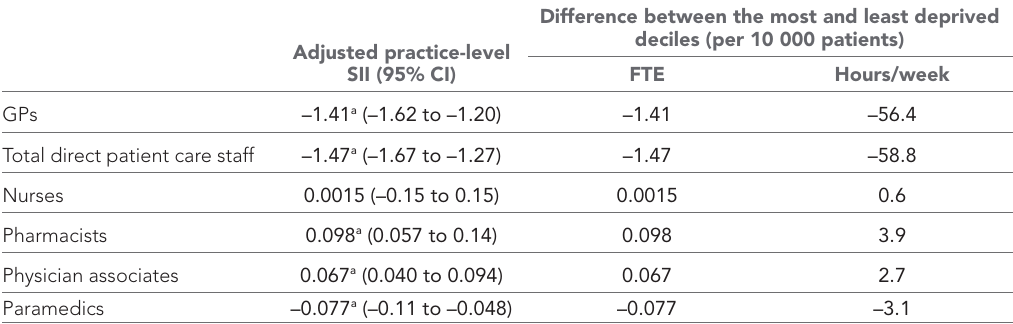
Table 1 Summary of practice- level results for December